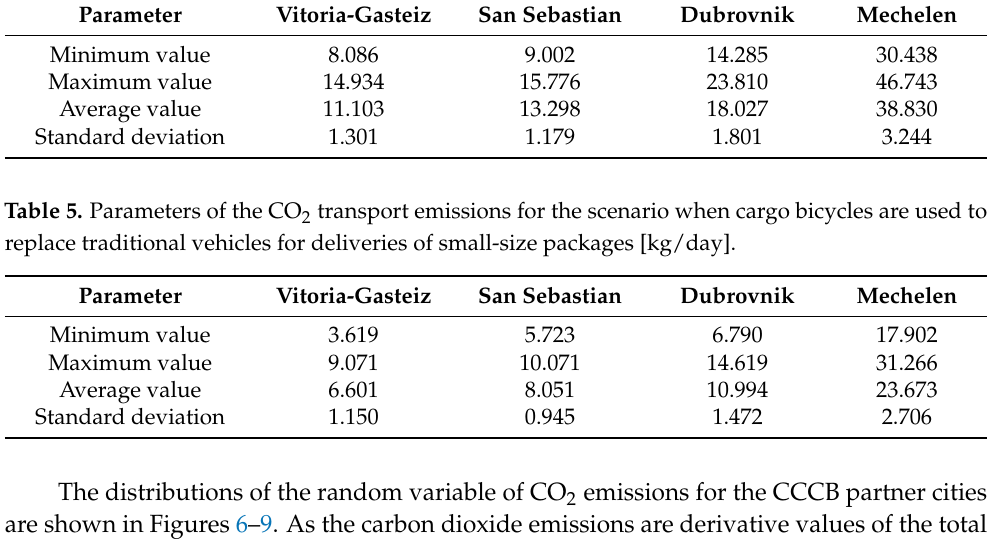
Table 5. Parameters of the CO 2 transport emissions for the scenario when cargo bicycles are used to replace traditional vehicles for deliveries of small-size packages [kg/day]. Table 4. Parameters of the CO 2 transport emissions for the basic scenario [kg/day]. Parameter